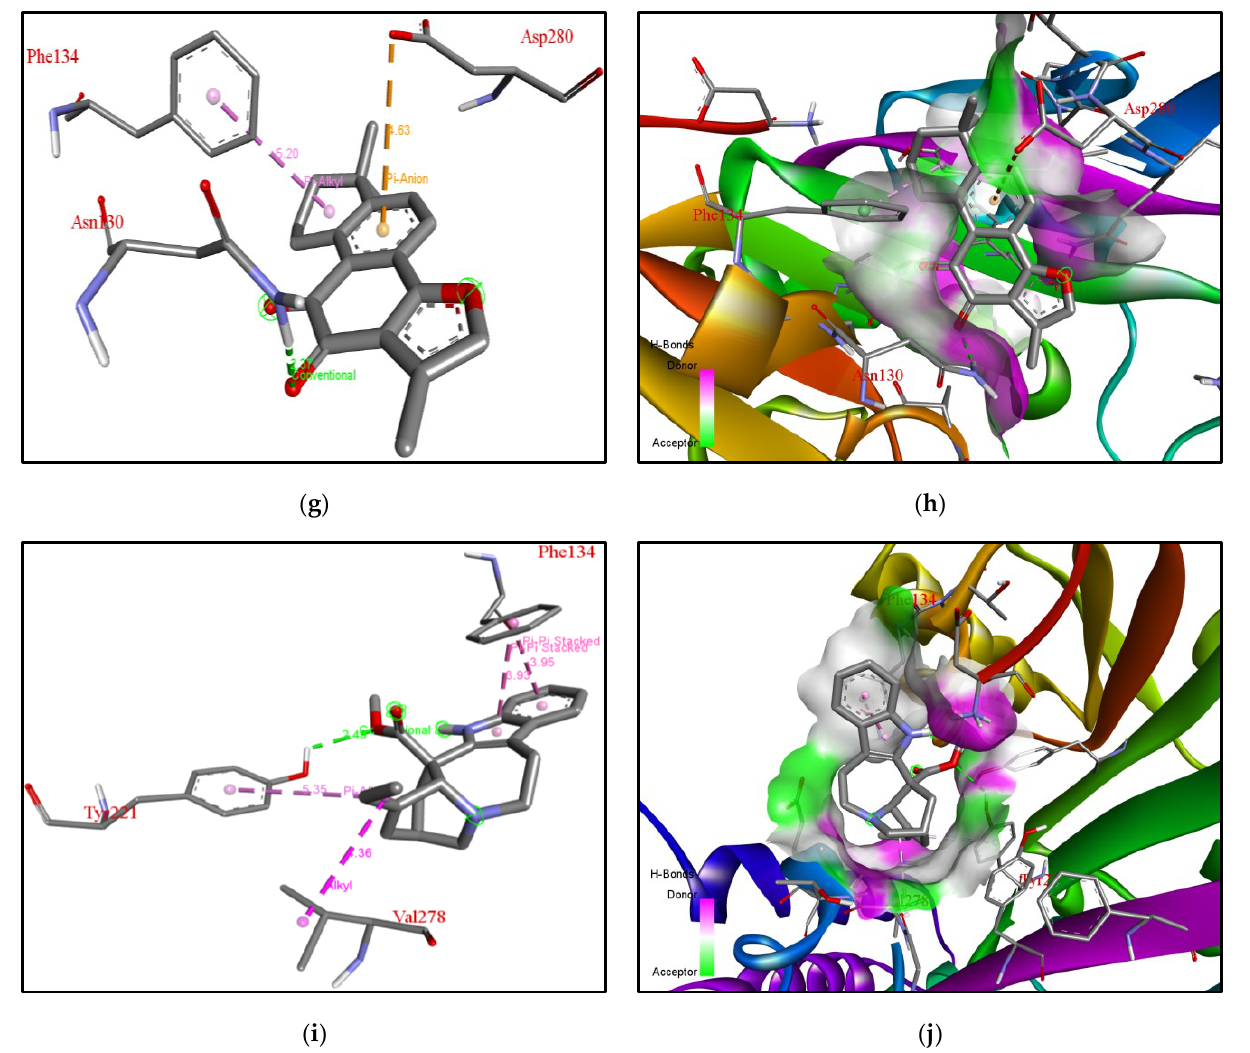
Figure 7. Analysis of docking pocket of XM-SMT: Interactions, bond lengths and hydrogen bond donor and acceptor around ligand binding pocket for XM SMT-ligand interaction are shown in these figures. ( a ) XM-cyclopamine interactions in red, pink, orange. ( b ) XM protein surface at proximity to ligand. ( c ) XM-chelerythrine alkyl interactions in pink., green, purple. ( d ) XM SMT protein surface at proximity to Chelerythrine colored pink or green based on Hydrogen bond donors or acceptors. ( e ) XM-berberine Alkyl interaction in metallic pink., green, pink. ( f ) XM SMT surface at proximity to Berberine ( g ) XM-Tanshinone 2 A interactions in yellow, pink, and green. ( h ) XM surface at proximity to Tanshinone 2 A pink or green based on Hydrogen bond donors or acceptors. ( i ) XM-catharanthine interactions in pink. ( j ) XM protein surface at proximity to Catharanthine pink or green based on hydrogen bond donors or acceptors.